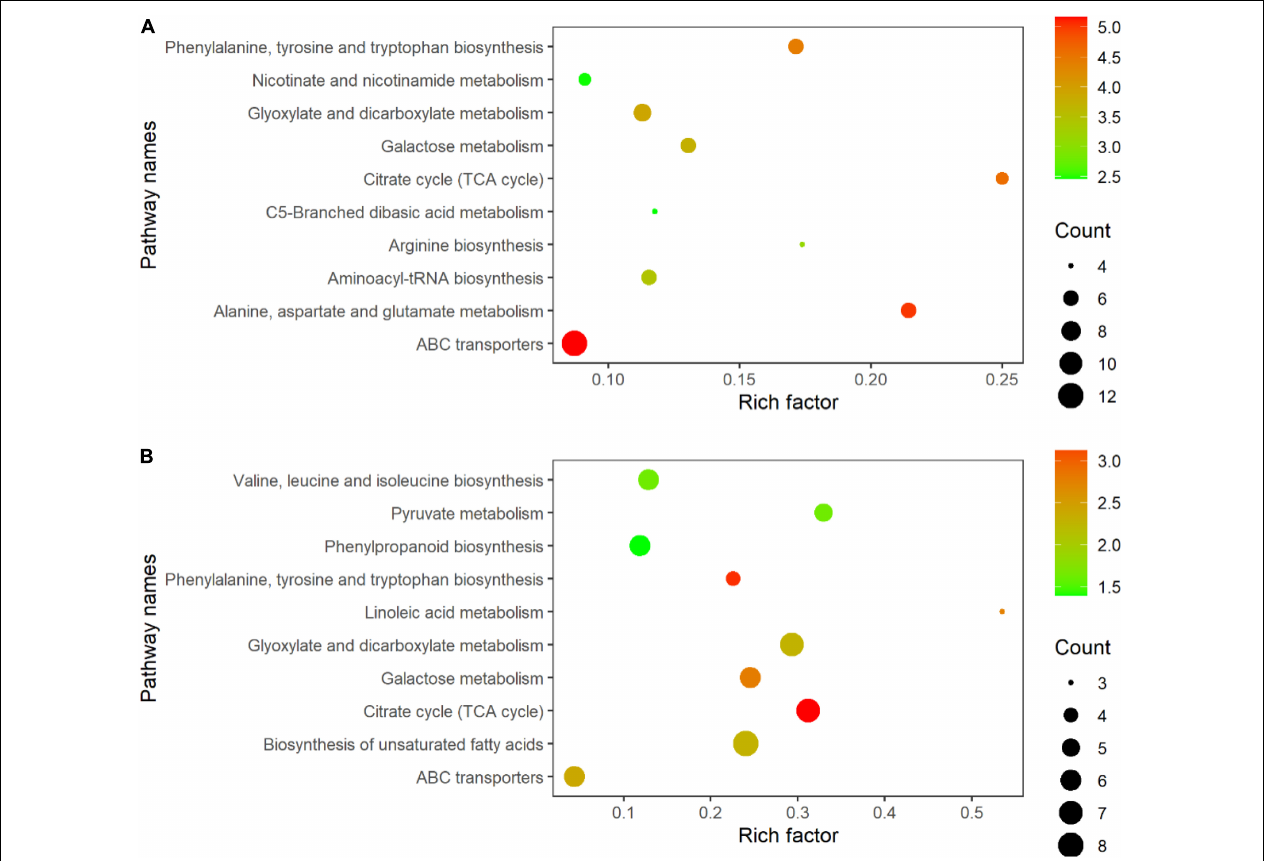
FIGURE 7 | KEGG pathway enrichment analysis of metabolites with differential abundance; (A) three-leaf stage; (B) tillering